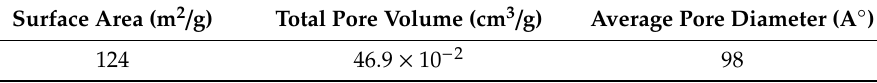
Table 1. Properties of the DSP